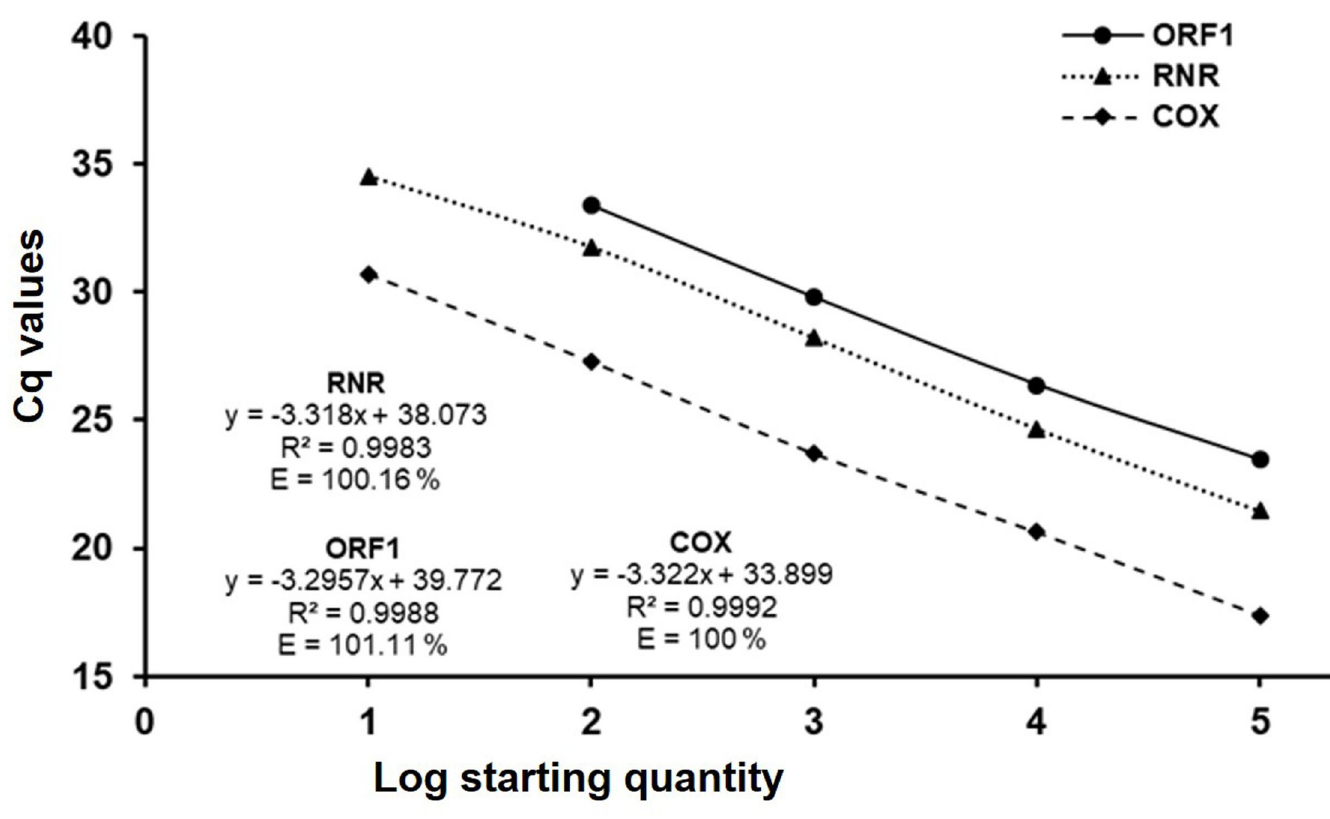
Fig 2. Calibration curve of triplex qPCR assays with tenfold serial dilution of “ Candidatus Liberibacter asiaticus” and Spiroplasma citri infected DNA (400 ng to 0.004 ng). Gene specific targets were RNR (dotted line) and ORF1 (unbroken line) for detection of C Las and S . citri , respectively, and COX (dash line) for citrus DNA.